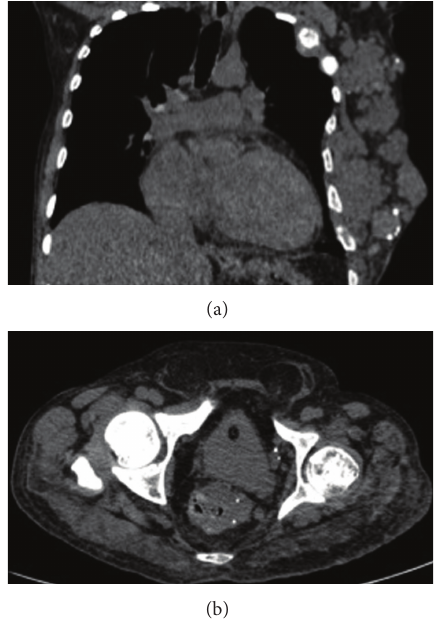
Figure 3: A 60-year-old man with Klippel-Trenaunay-Weber syn- drome presenting asymmetric growth of the lower limbs. CT of the chest showed increased soft tissue as well as extensive vascu- lar malformations in the left hemithorax wall with intermingled phleboliths, causing multiple lytic lesions with enlargement in the ipsilateralribs(a).CToftheabdomenshowedathick-walledrectum intermingled with phleboliths, denoting varicose veins